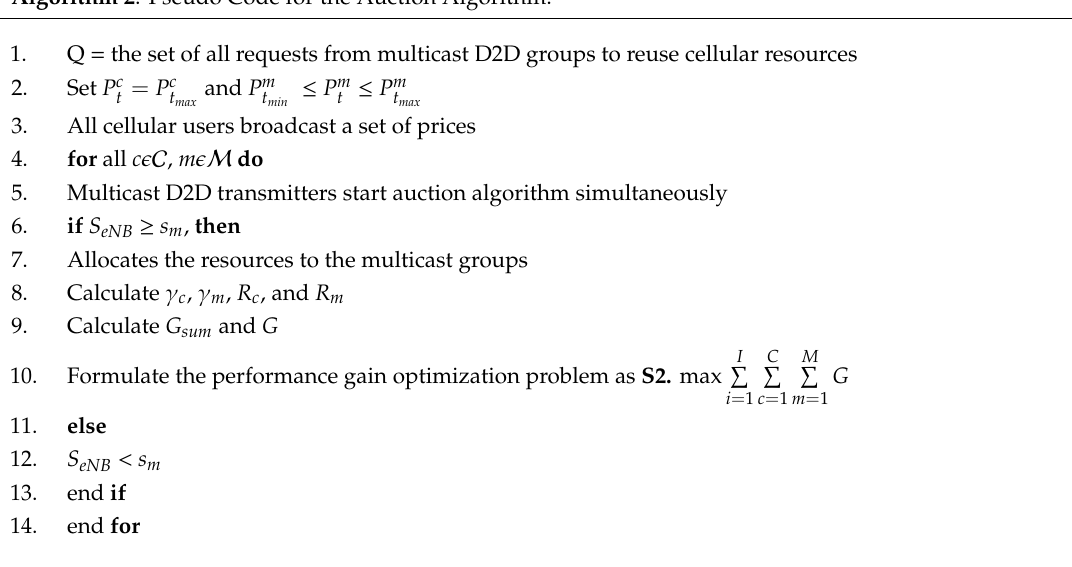
Algorithm 2 : Pseudo Code for the Auction